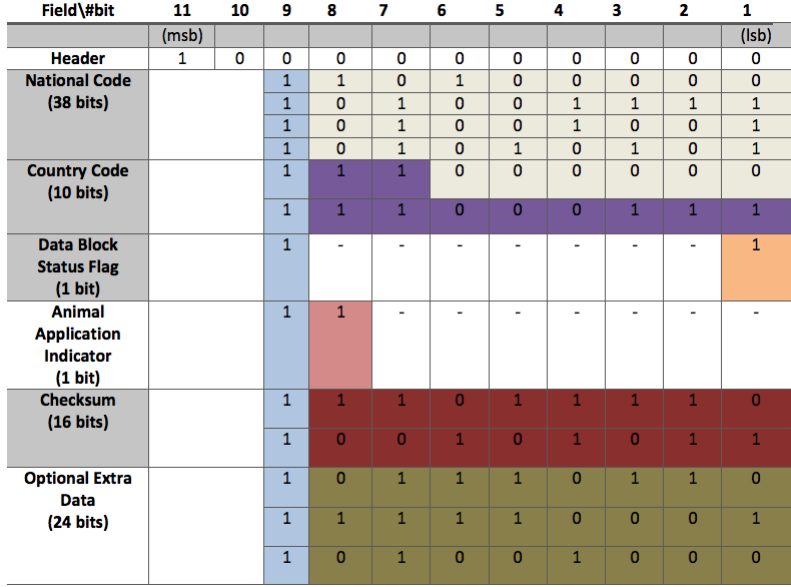
Figure 24. Internal memory structure of an animal identification